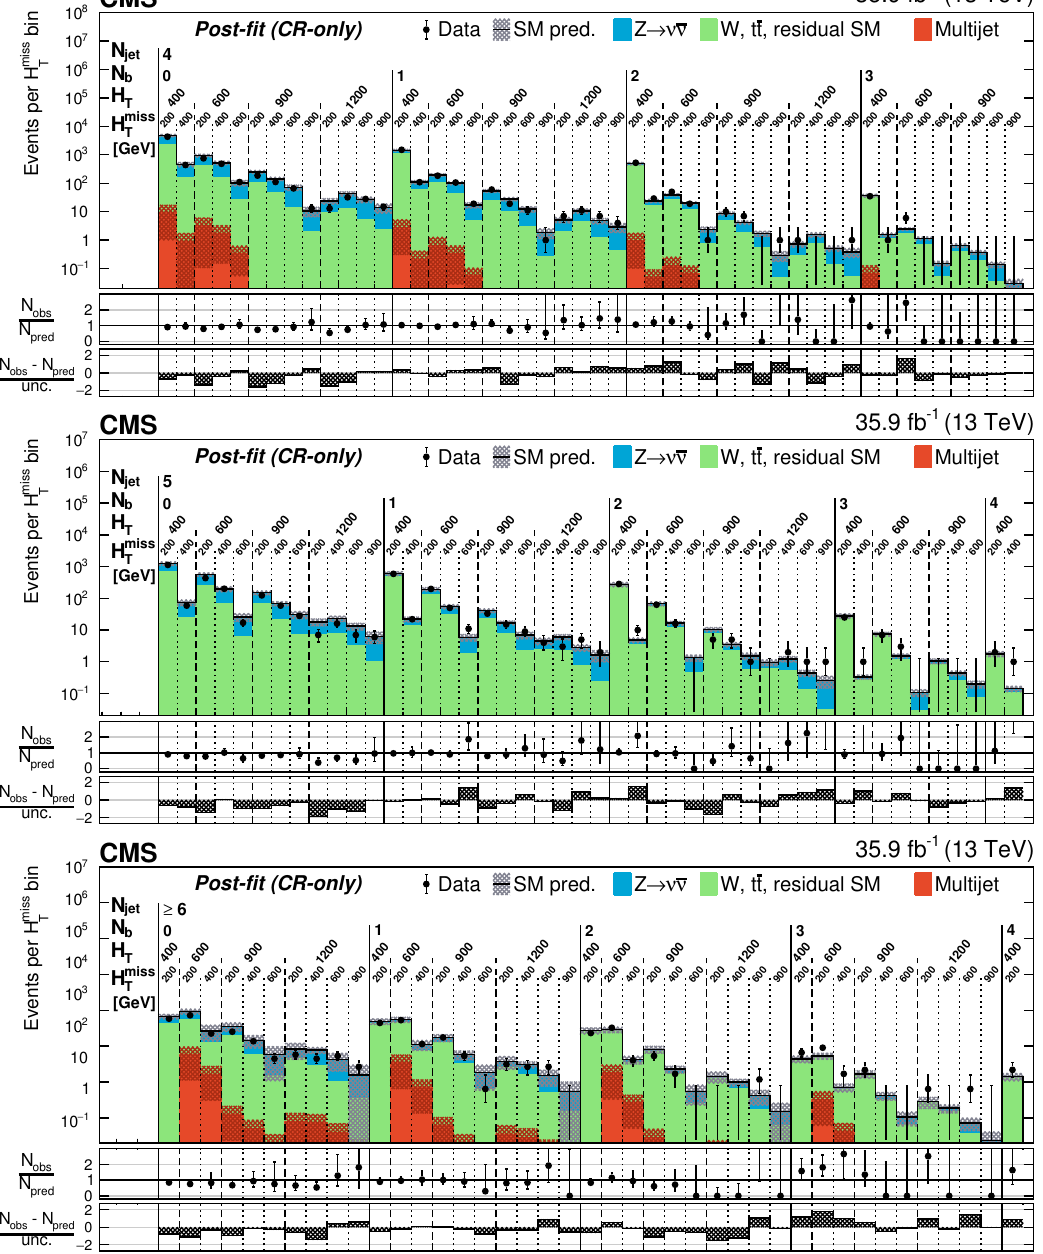
Figure 2 . Counts of signal events (solid markers) and SM expectations with associated uncer- tainties (statistical and systematic, black histograms and shaded bands) as determined from the CR-only (cid:12)t as a function of n b , H T , and H miss for the event categories n jet = 4 (upper), = 5 T (middle), and (cid:21) 6 (lower). The lower panels are described in the caption of (cid:12)gure 1.